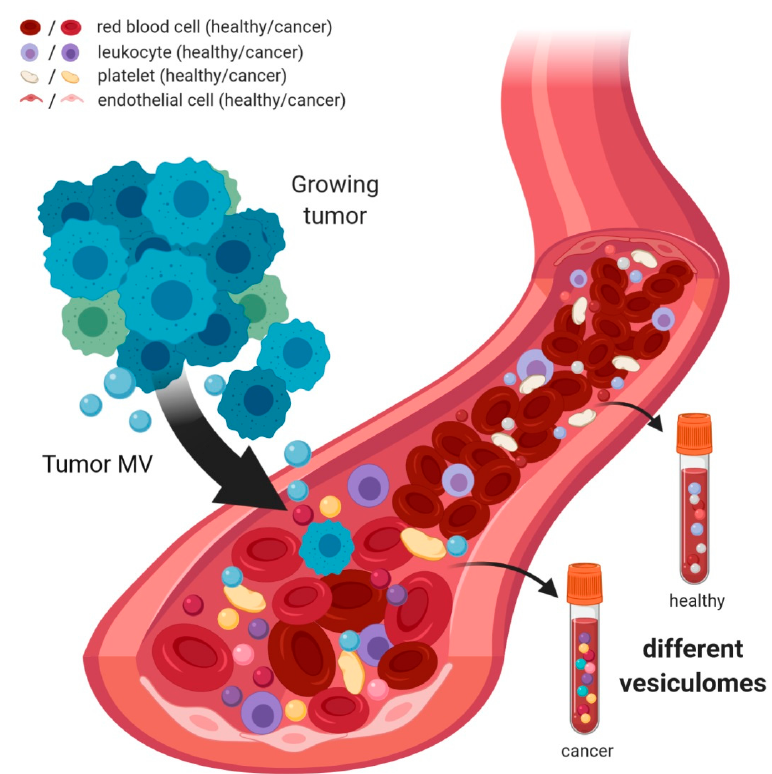
Figure 2. The microvesiculome in blood. The growth of a tumor is accompanied by secretion of circulating tumor cells (CTCs) as well as of tumor-derived soluble factors and MV. When encountering any of these components, benign blood cells can become activated and react by shedding their own, altered MV. Taken together, this results in changes in the composition as well as expression pattern of MV in the blood of cancer patients. Liquid biopsy-based MV sampling should therefore not only be focused on the detection of tumor MV, but also on alterations in non-tumor blood MV.